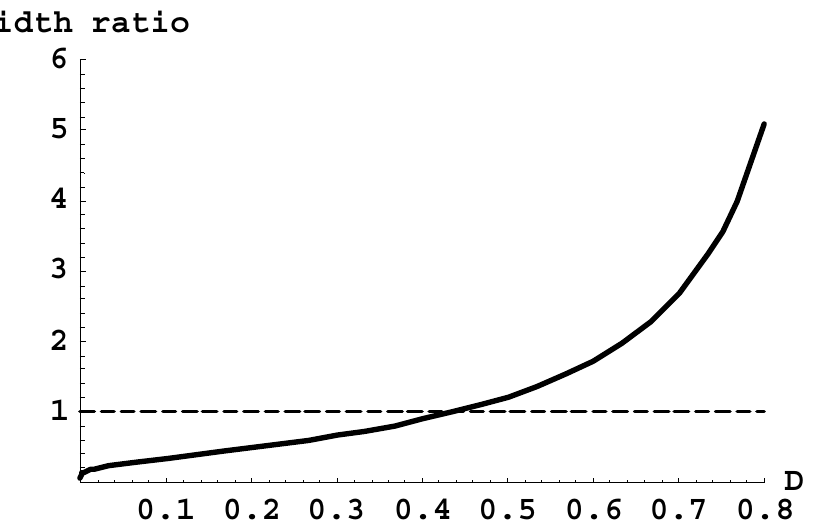
Figure 19. The ratio of adiabatic widths γ αβ ,hel / γ αβ ,rec versus the dimensionless parameter D, which is defined by Equation (10.18) and which is physically the ratio ρ Wad (v T )/ ρ D (solid curve). The dashed horizontal line is there for better visualizing the two regions: γ αβ ,hel / γ αβ ,rec < 1 and γ αβ ,hel / γ αβ ,rec > 1 [101].